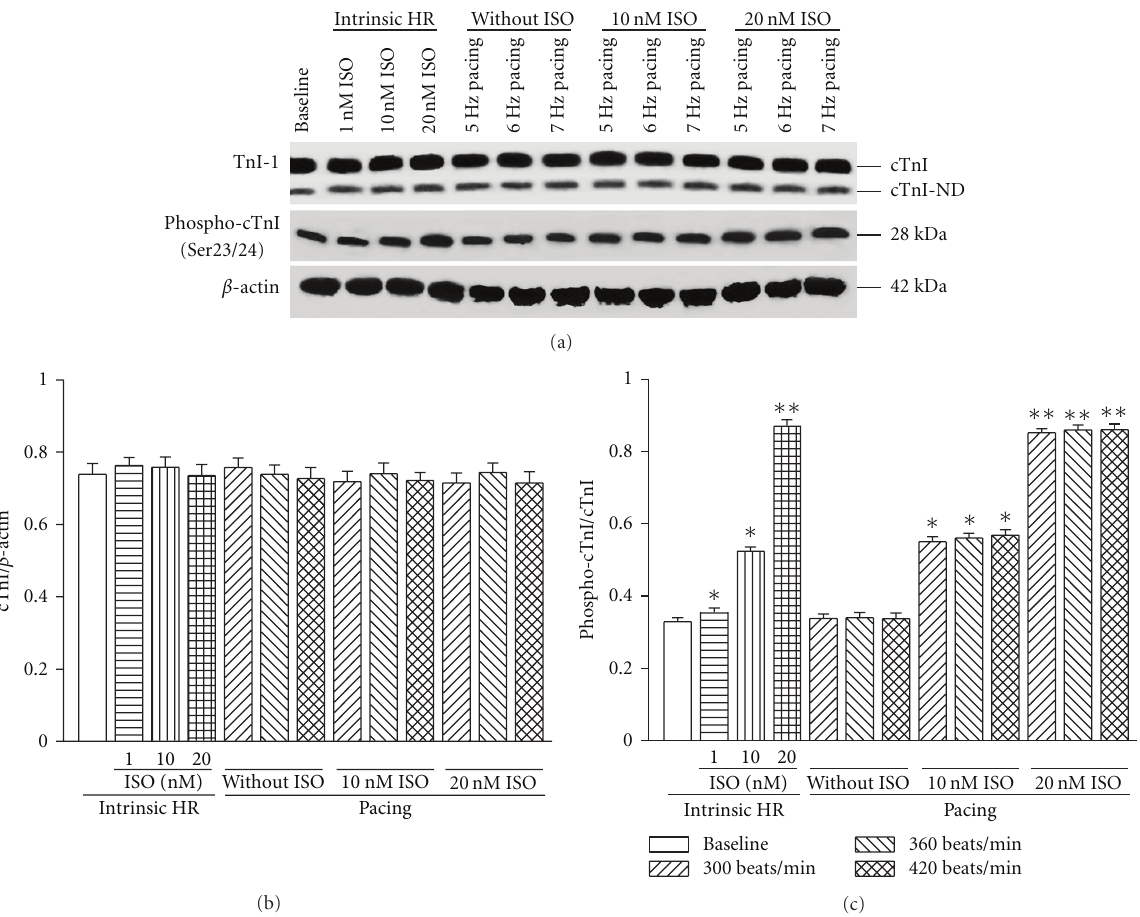
Figure 6: Expressions of cTnI and phosphorylated cTnI at Ser23/24 in the myocardium after the pacing and ISO treatment. (a) The representative Western blots of cTnI and phosphorylated cTnI at Ser23/24. (b) Expression of total cTnI which is the sum of cTnI and NH 2 -terminal deleted fragment of cTnI (cTnI-ND). (c) The phosphorylation of cTnI. Data are mean ± SEM, n = 6 hearts in each group. ∗ P < 0 . 05 or ∗∗ P < 0 . 01 versus